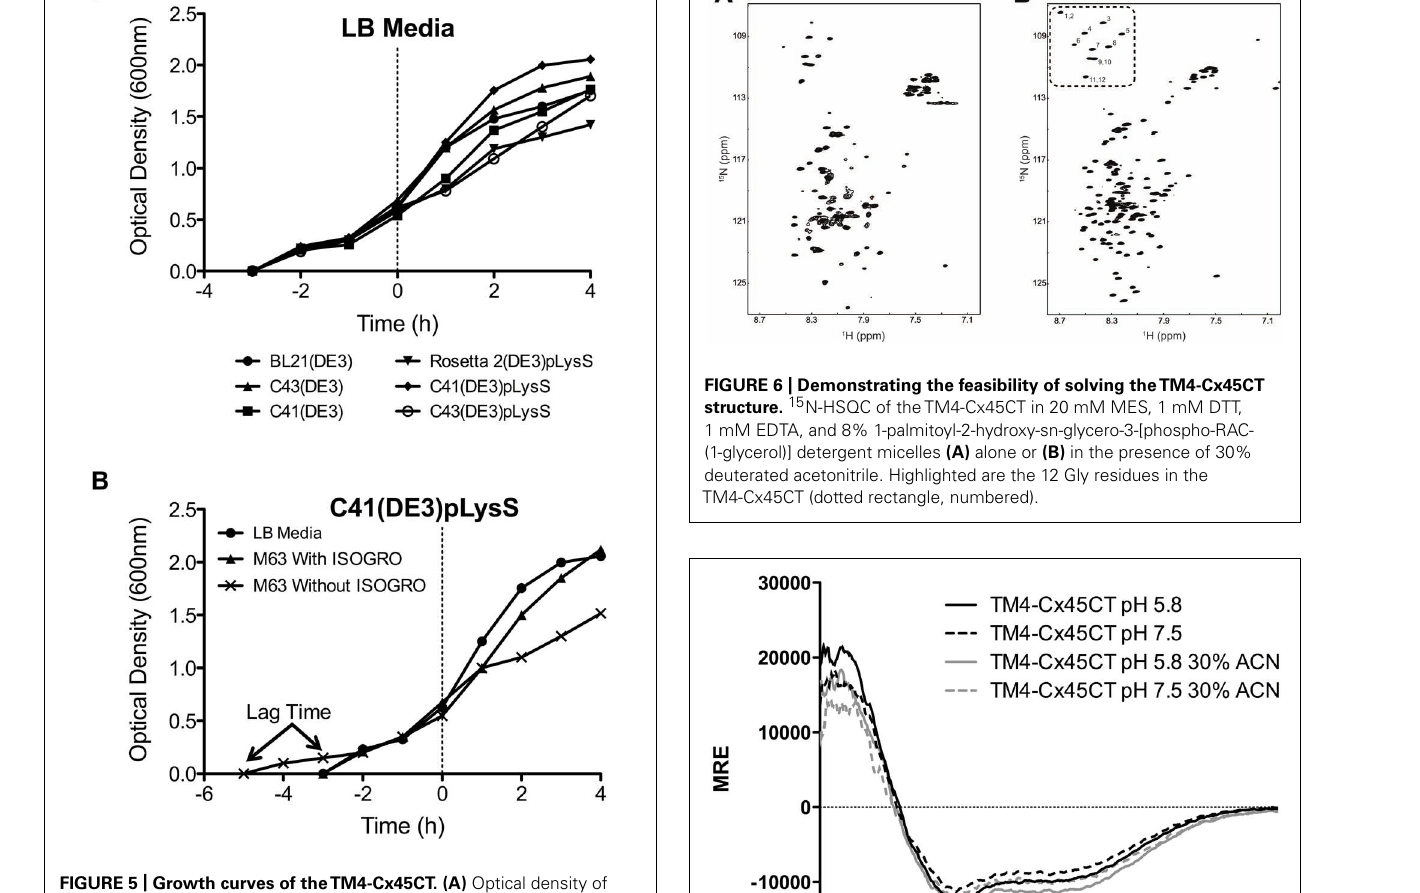
FIGURE 5 | Growth curves of theTM4-Cx45CT. (A) Optical density of cultures in LB media were monitored at Abs 600 nm during the growth of TM4-Cx45CT in six different E. coli strains. (B) TM4-Cx45CT grown in the C41(DE3)pLysS stain using LB and M63 minimal media with or without ISOGRO.The dashed line at 0 h represents the induction with IPTG.